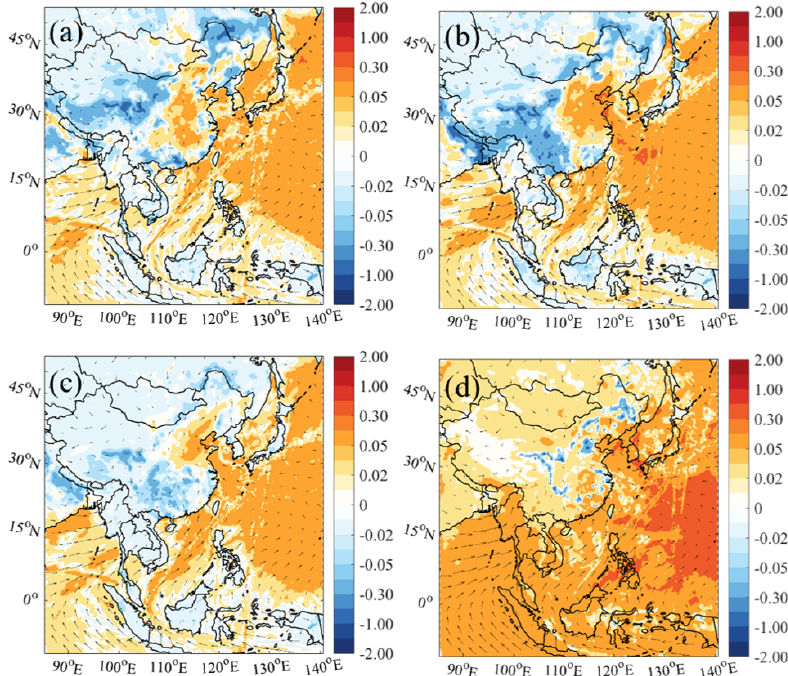
Figure 4. Averaged daytime RO x changes due to ship emissions (06:00–18:00LST; in pptv) with (a) default chemistry (Def − Def_noship), (b) default and additional HONO chemistry (HONO − HONO_noship), (c) default and additional chlorine chemistry (Cl − Cl_noship), and (d) default and combined HONO and chlorine chemistry (BASE − BASE_noship). The arrows present simulated wind vectors from the BASE case.